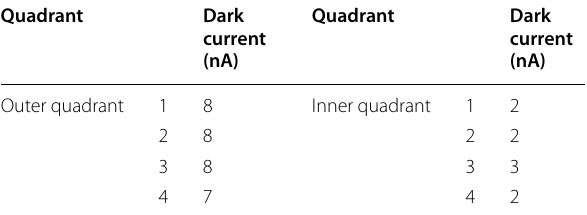
Table 4 Test results of response speed Quadrant Rising Outer